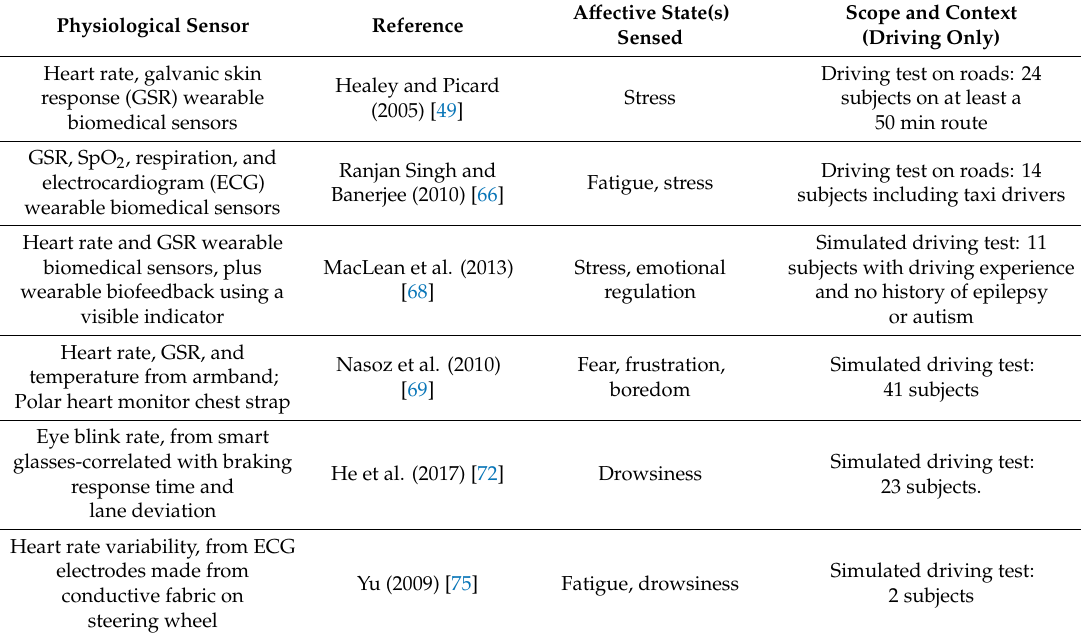
Table 2. Wearable / in-vehicle physiological sensors and the connection between the sensed signal and a ff ective